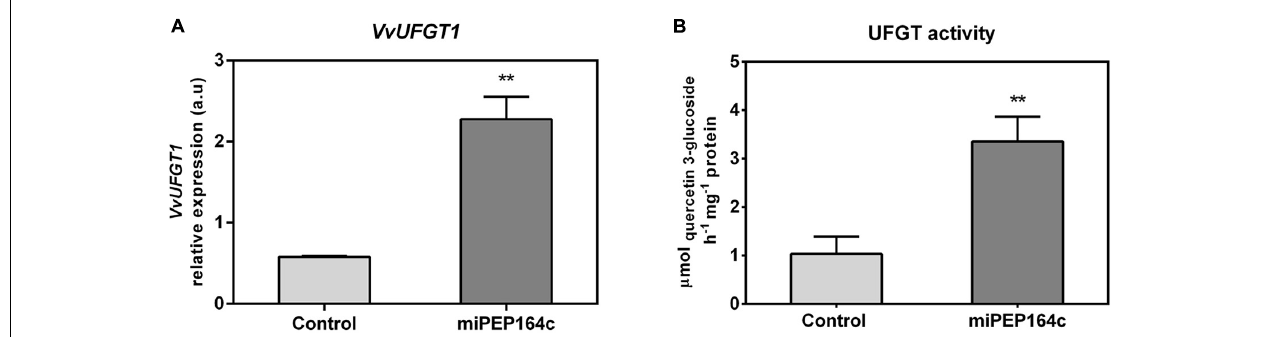
FIGURE 5 | Steady-state transcript levels of VvUFGT1 (A) in suspension-cultured grape berry cells (cv. Gamay) 10-day after elicitation with 1 µ M miPEP164c and the effect on the specific activity of UDP-glucose flavonoid 3-O-glucosyltransferase (UFGT). (B) Gene expression analysis, by real-time qPCR was normalized with the expression of reference gene VvACT1 and VvGAPDH . Values are the mean ± SEM. Asterisks indicate statistical significance (Student’s t -test; ** P < 0.01). UFGT biochemical activity, represented as the V max in grape berry cells under miPEP164c treatment. Values are the mean ± SEM. Asterisks indicates statistical significance (Student’s t -test; ** P <